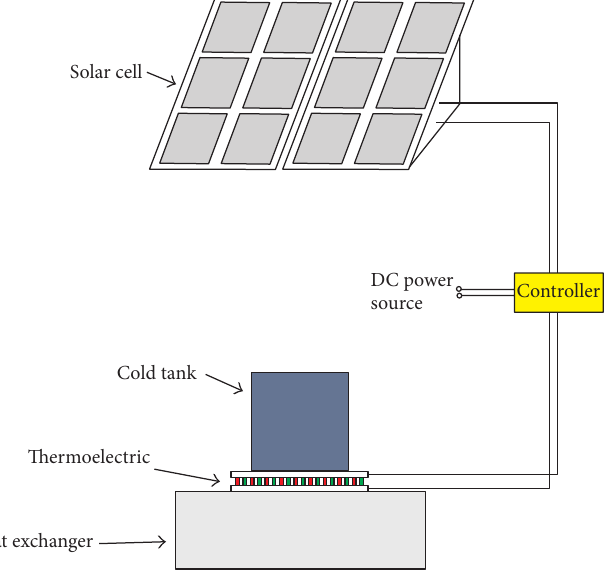
Figure 1: Solar thermoelectric